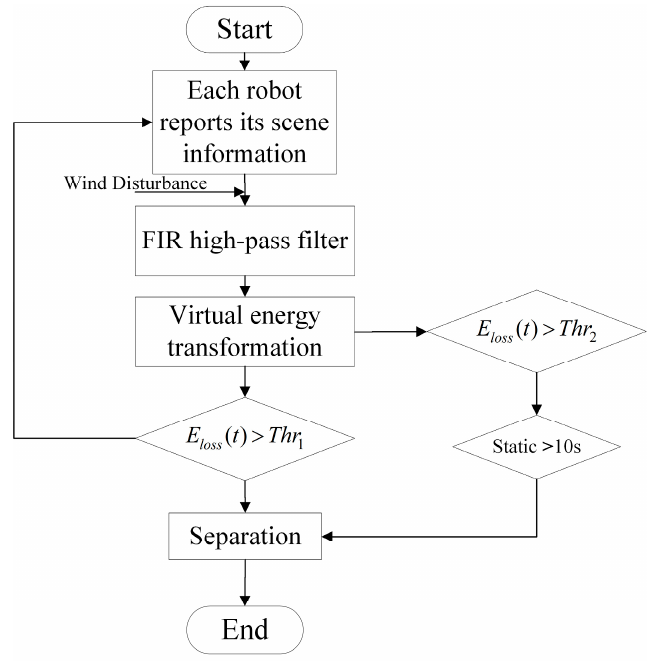
Figure 10. Flowchart of the separation control algorithm.